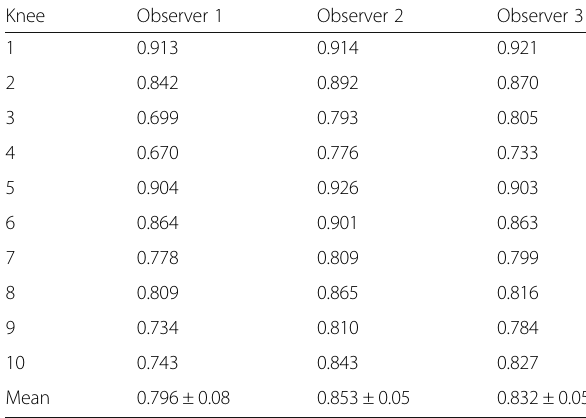
Table 3 Dice coefficient Interobserver variability spectral unmixed